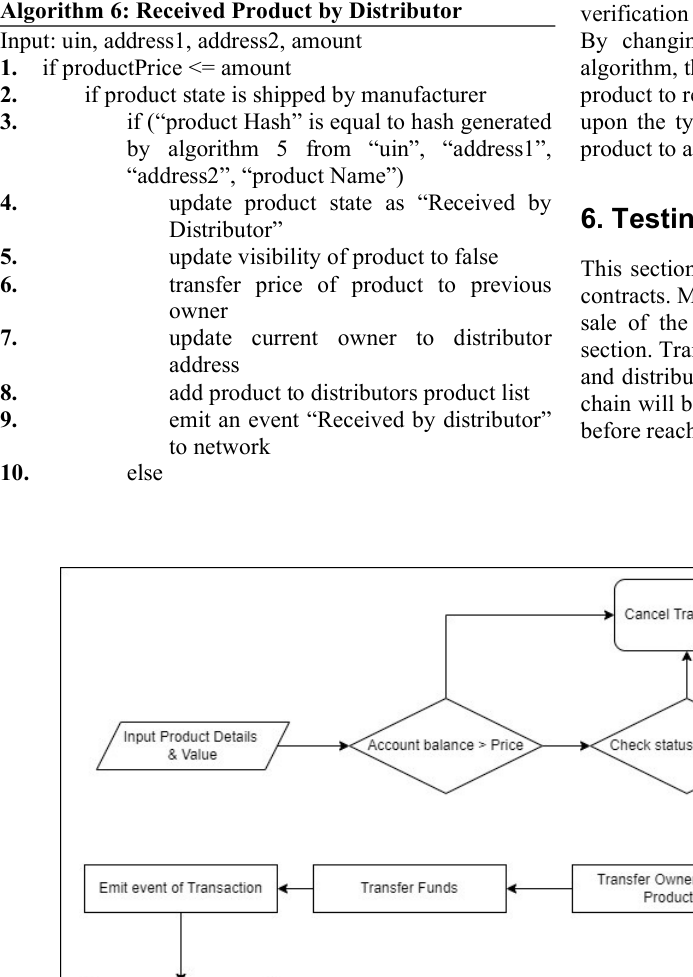
Algorithm 6: Received Product by Distributor